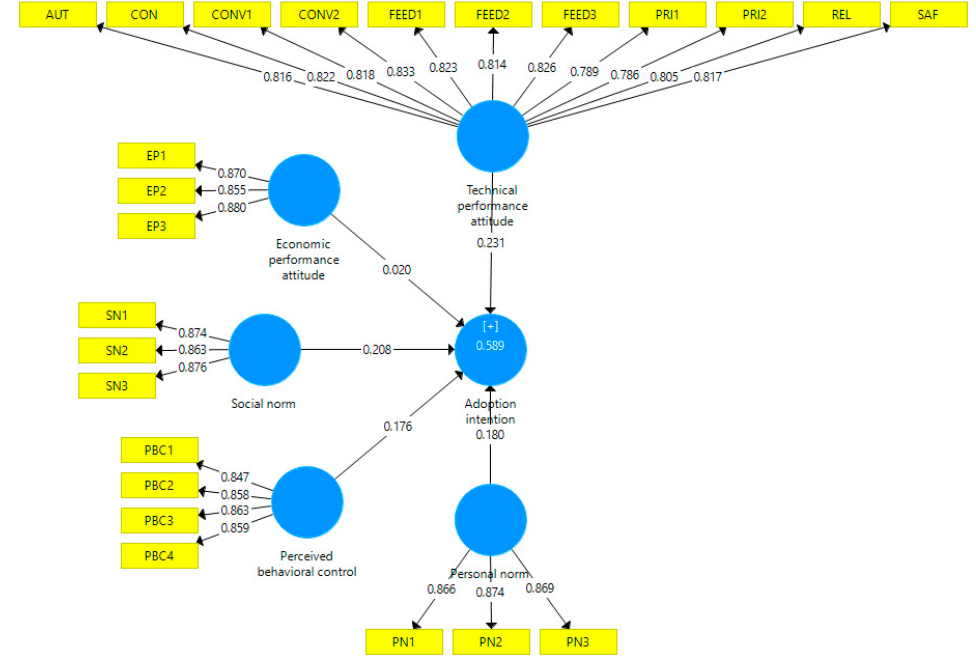
Figure 3. PLS-SEM [89] results of path coe ffi cients and indicator